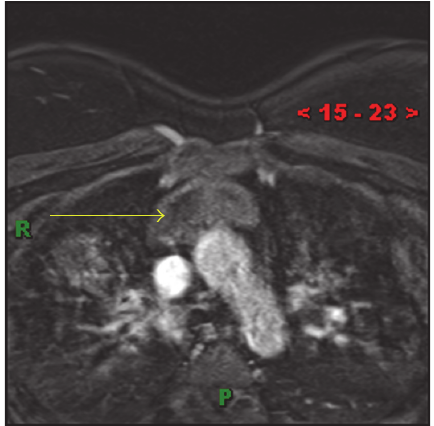
Figure 4: (MR T1 postcontrast) heterogeneous anterior mediastinal mass (yellow arrow) without obvious enhancement.